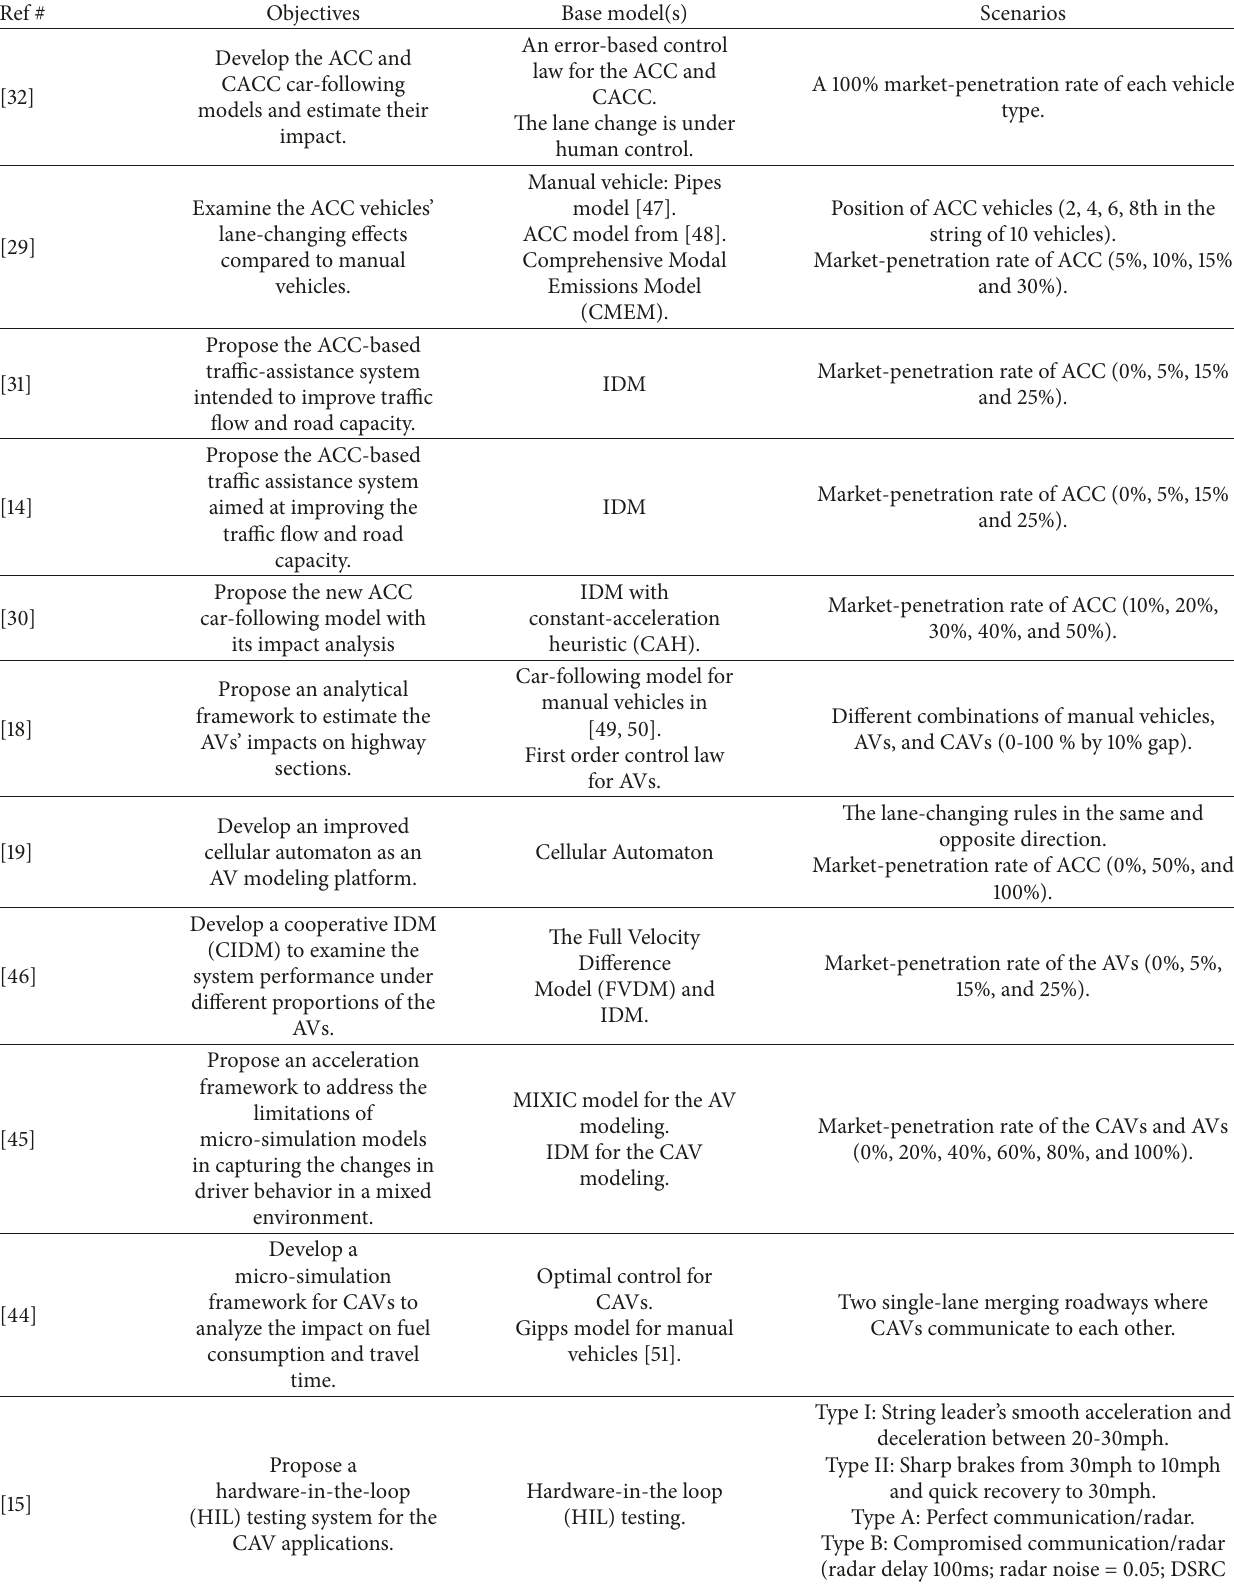
Table 1: Simulation-based intelligent-vehicle studies: objectives, models, and